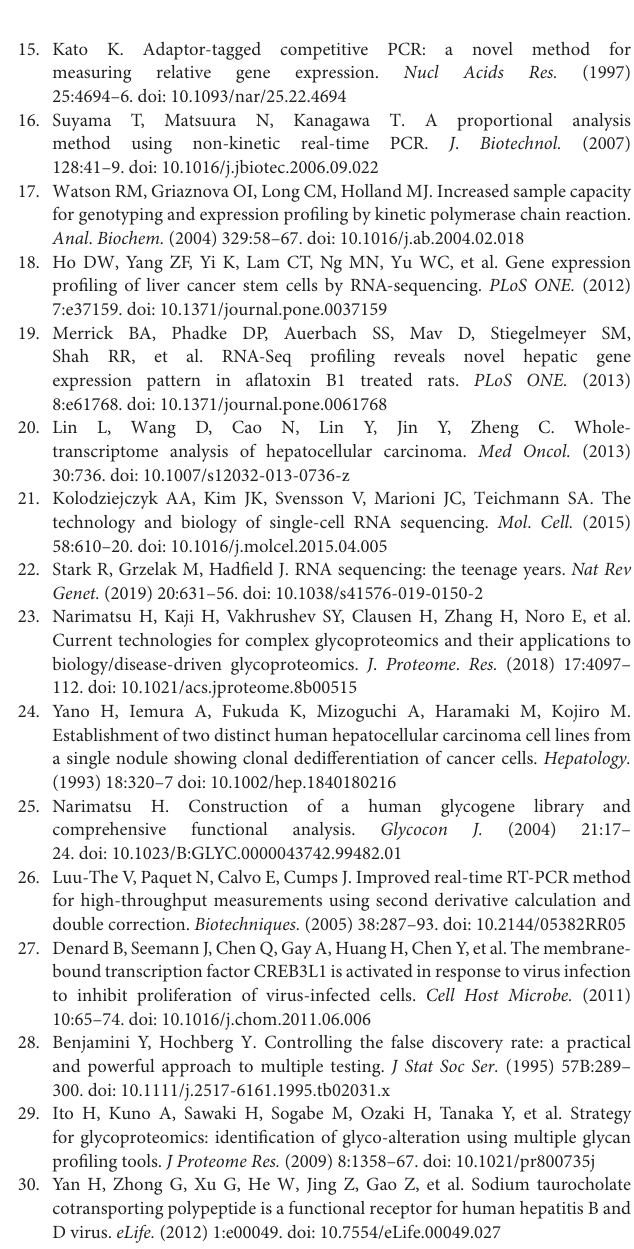
described in “MATERIALS AND METHODS.” Patients 1–11 are stage i, patients 12–19 are stage ii, and patients 20–31 are stages iii, iiia, and iv. Table S1 | Comparison of expression profiles obtained from qRT-PCR and RNA-Seq. Table S2a | Expression difference between PHH and HuH7 cells for Figure 5A . Table S2b | Expression difference between PHH and HepG2 cells for Figure 5B . Table S3 | Expression profile of glycogenes from hepatic cells. Table S4 | Comparison of expression of glycogenes and biomarker candidates in RNA-Seq data extracted from